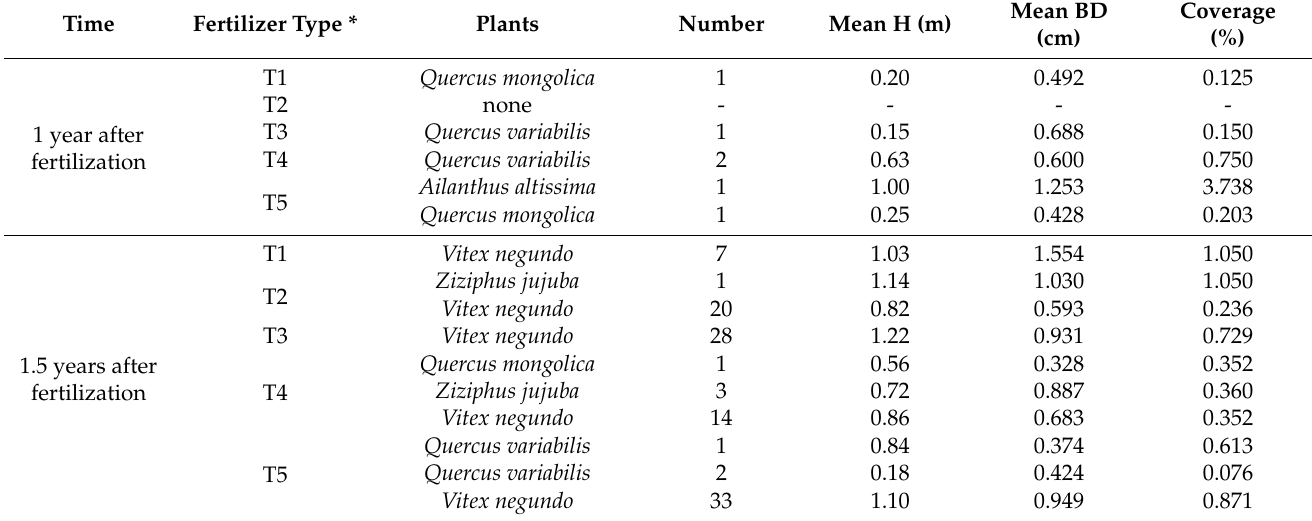
Table 6. Regeneration of Pinus tabuliformis